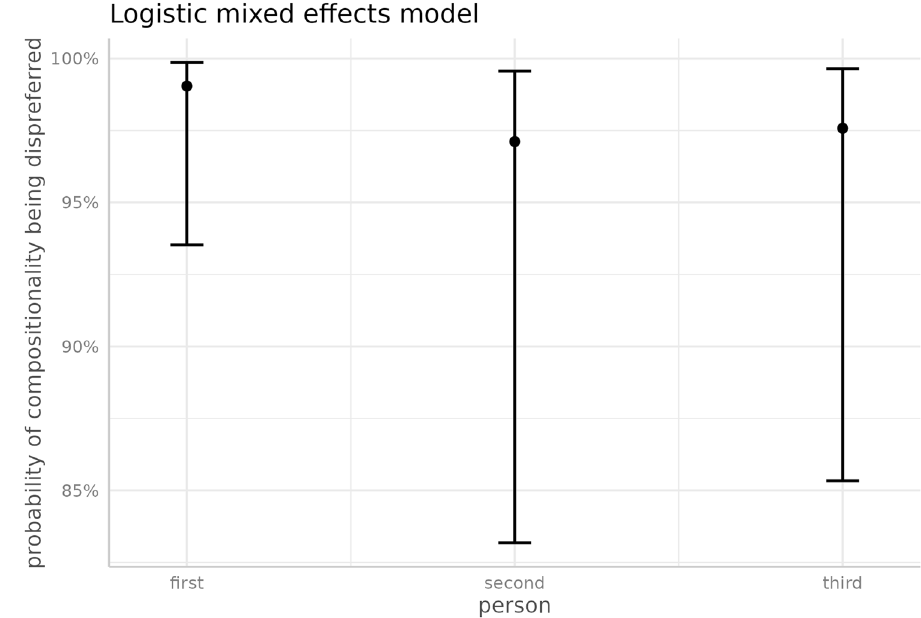
Fig. 5 Probability of compositionality of the modern form depending on the person and compositionality of the